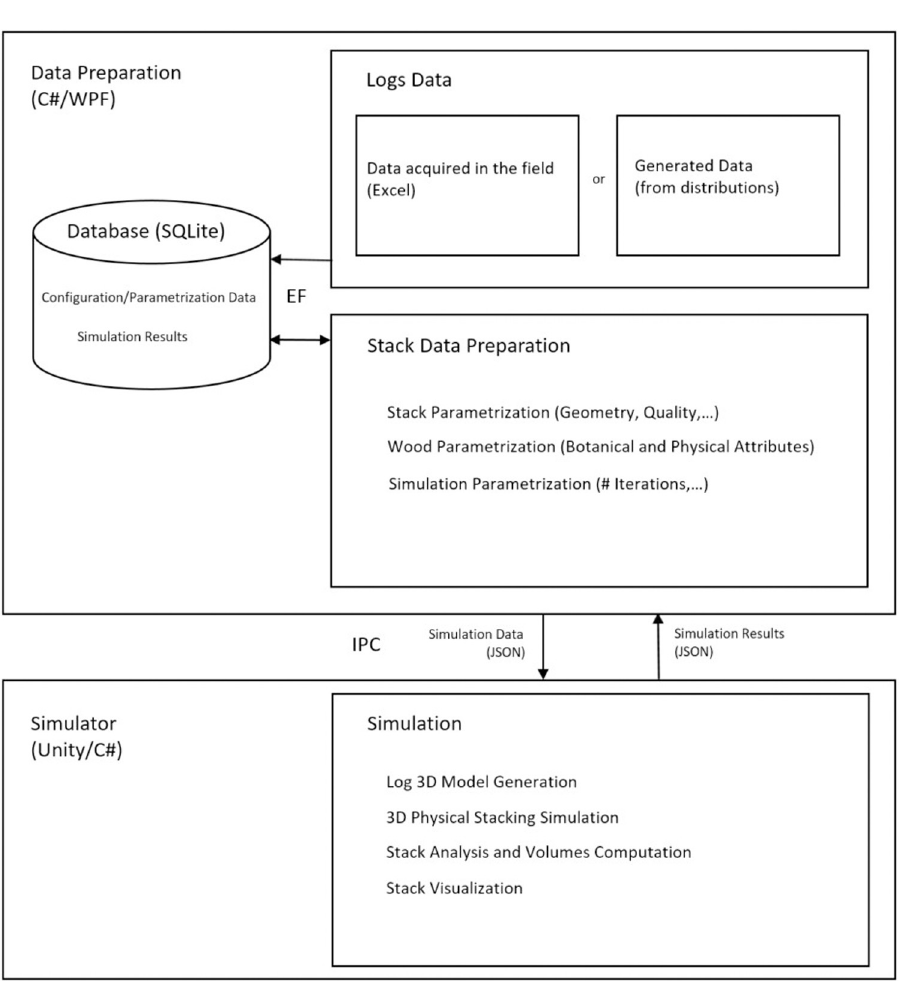
Fig 1. Flowchart of the simulation process and the software